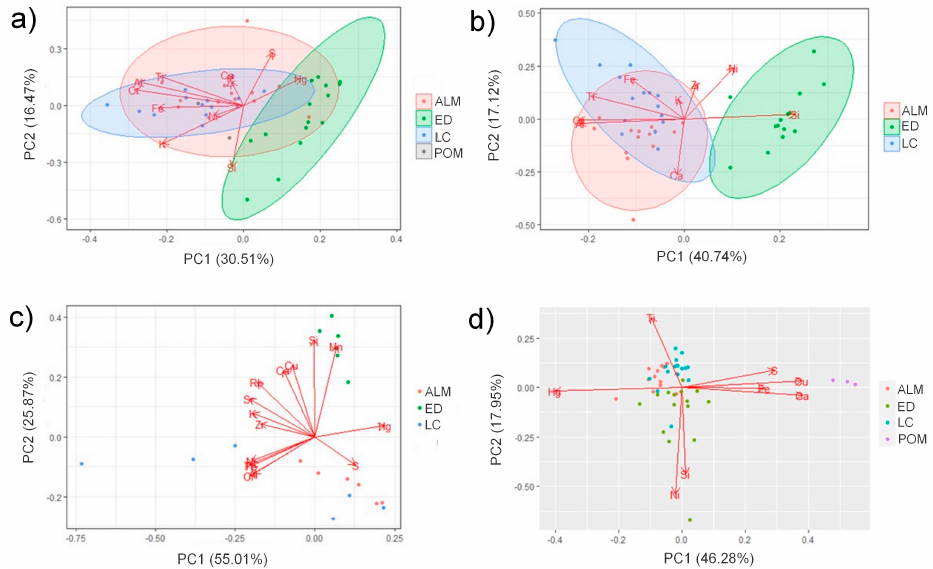
Figure 9. Scores and loadings plot of: ( a ) the cinnabar ores and the raw pigment from Pompeii using the semi-quantitative dataset from benchtop EDXRF spectrometer, ( b ) the cinnabar ores using the semi-quantitative dataset from benchtop EDXRF spectrometer excluding Hg, ( c ) the cinnabar ores using the dataset (normalized counts) from HH-EDXRF spectrometer, ( d ) the powdered cinnabar ore samples and the raw pigment from Pompeii using the dataset (normalized counts) from benchtop EDXRF spectrometer.